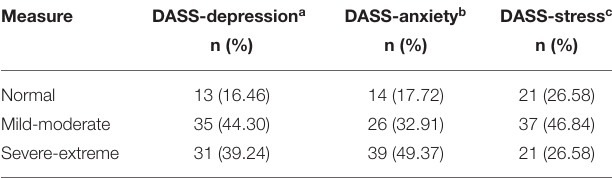
TABLE 3 | Frequency and proportion of participants in each DASS-42 clinical cut-off category. Measure